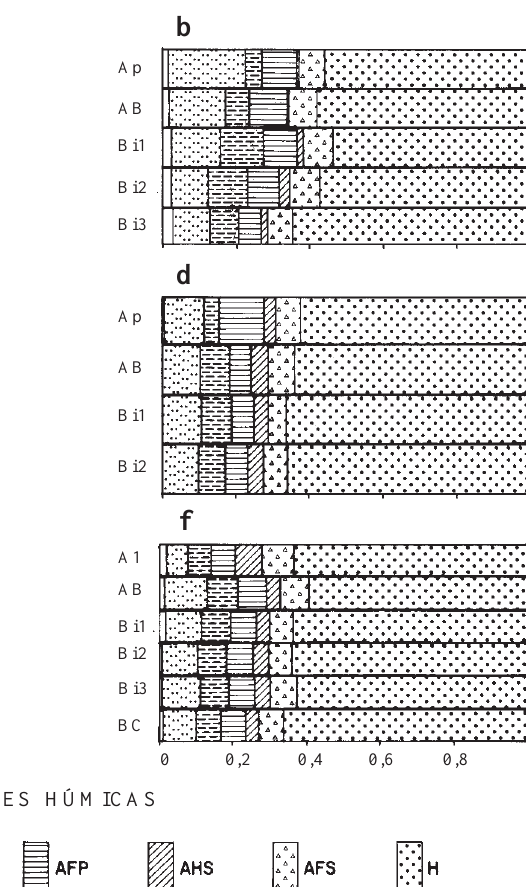
Figura 3. Frações do húmus em percentagem relativa do carbono total no a) P1, b) P2, c) P3, d) P4, e) P5, f) P6. ML: matéria orgânica leve; AFL: ácidos fúlvicos livres; AHP: ácidos húmicos piro; AFP: ácidos fúlvicos piro; AHSL: ácidos húmicos soda; AFS; ácidos fúlvicos soda; H: humina.cto de sílica (amorfa ou colidal) em alguns poros e intercrescimento de grãos de